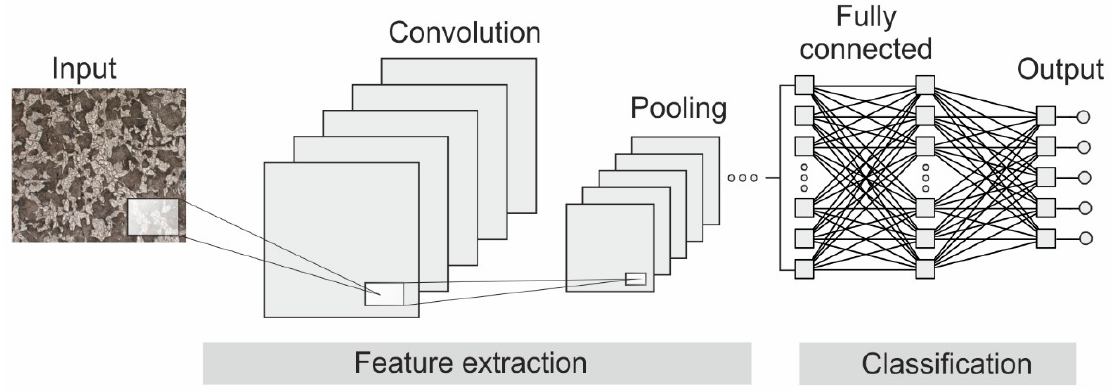
Figure 6. Typical topology of convolutional neural network.